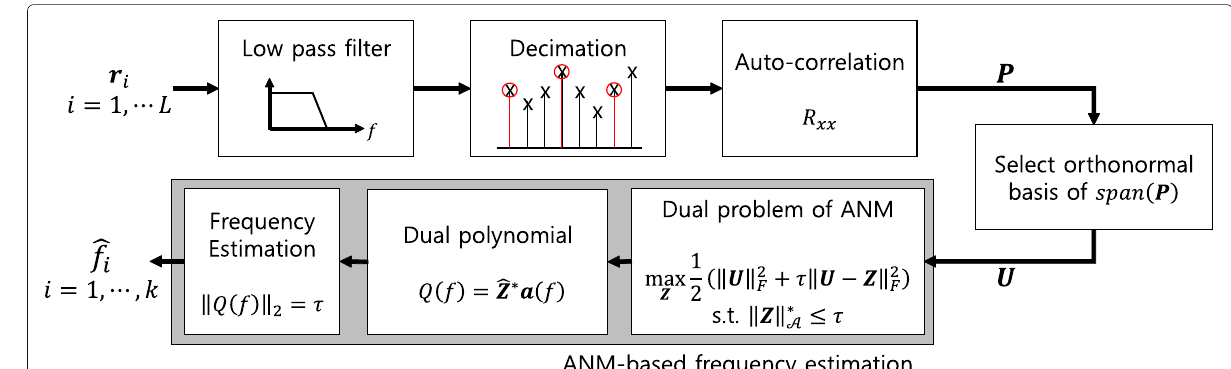
Fig. 2 Block diagram of the passive sonar systems using proposed frequency estimation